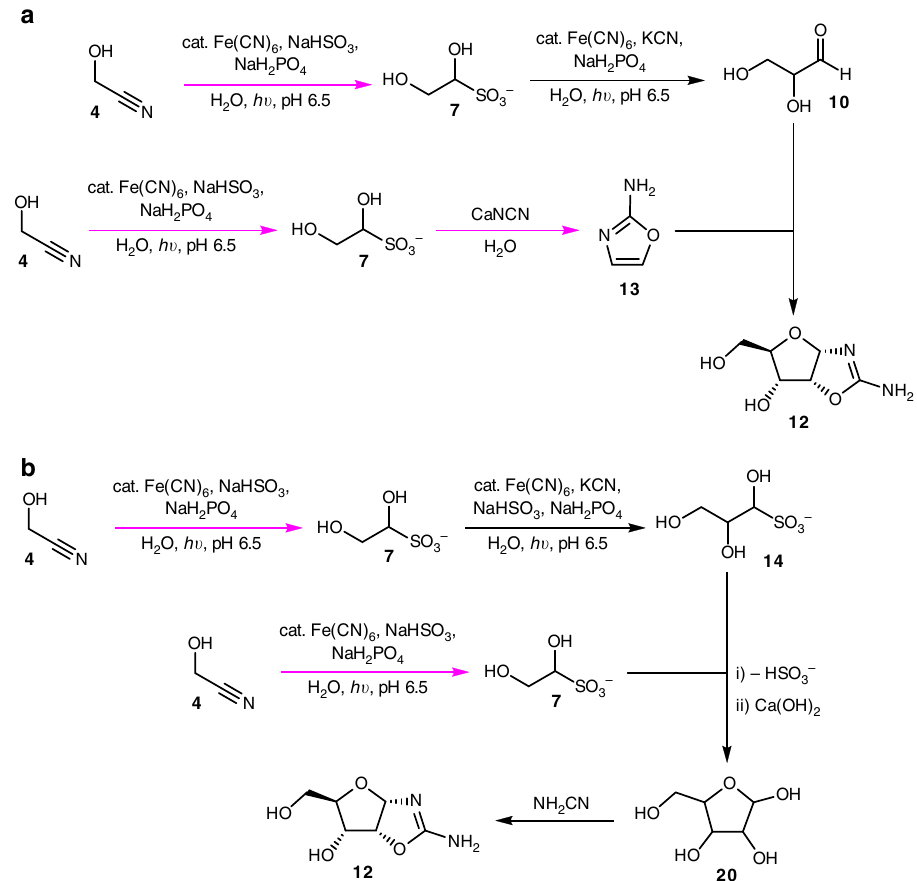
Fig. 9 The two viable routes to ribo- aminooxazoline 12 starting from 4 . All steps have been demonstrated under batch conditions, but those steps depicted in magenta have been performed in fl ow conditions in a “ continuous ” 48 , uninterrupted manner starting from glycolonitrile 4 or HMSA 9 . a Route to 12 via the addition of 2-AO 13 to glyceraldehyde 10 . b Route to 12 via aldol reaction of 5 and 10 after their liberation from 7 and 14 ,